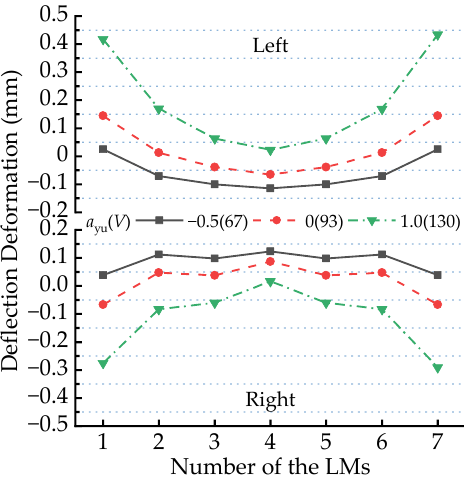
Figure 11. Distribution of deflection deformation amplitudes of the LMs passing through the R650 m circular curve at various running speeds.